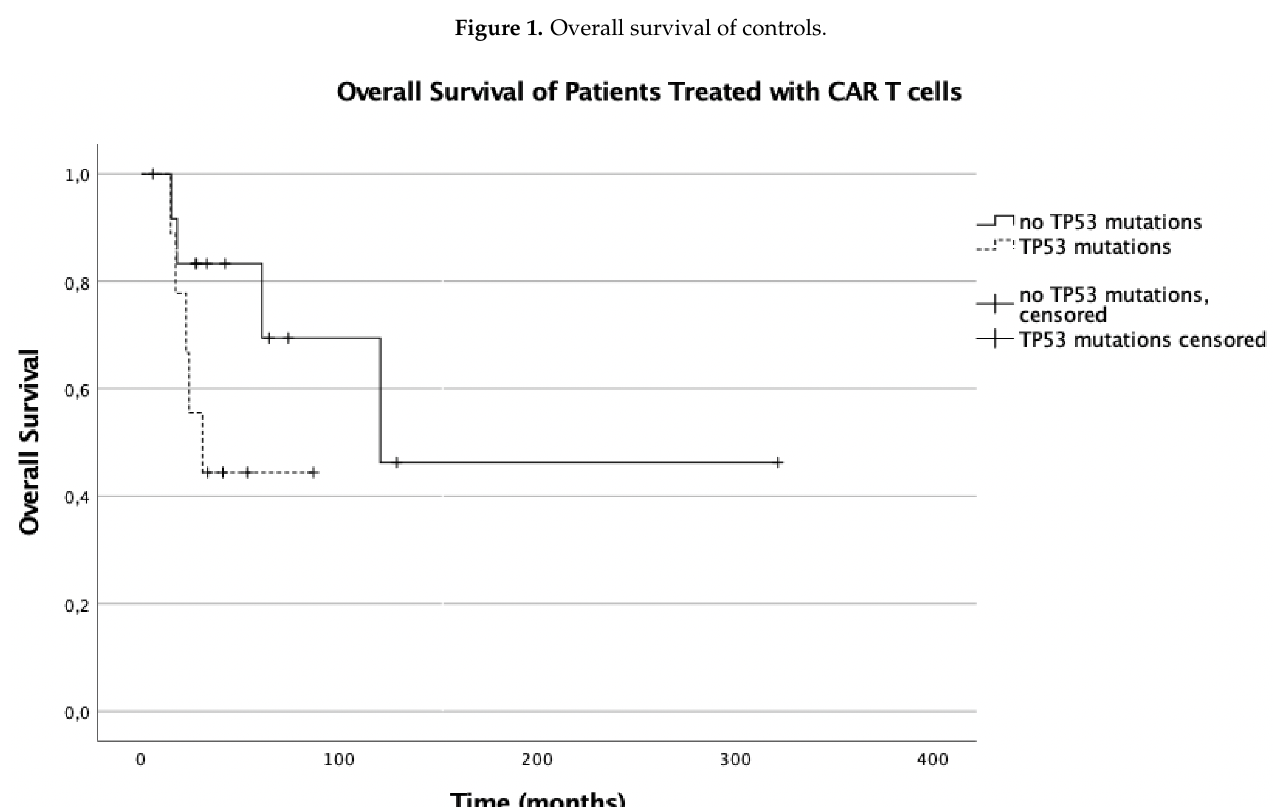
Figure 2. Overall survival of patients treated with CAR T cells.